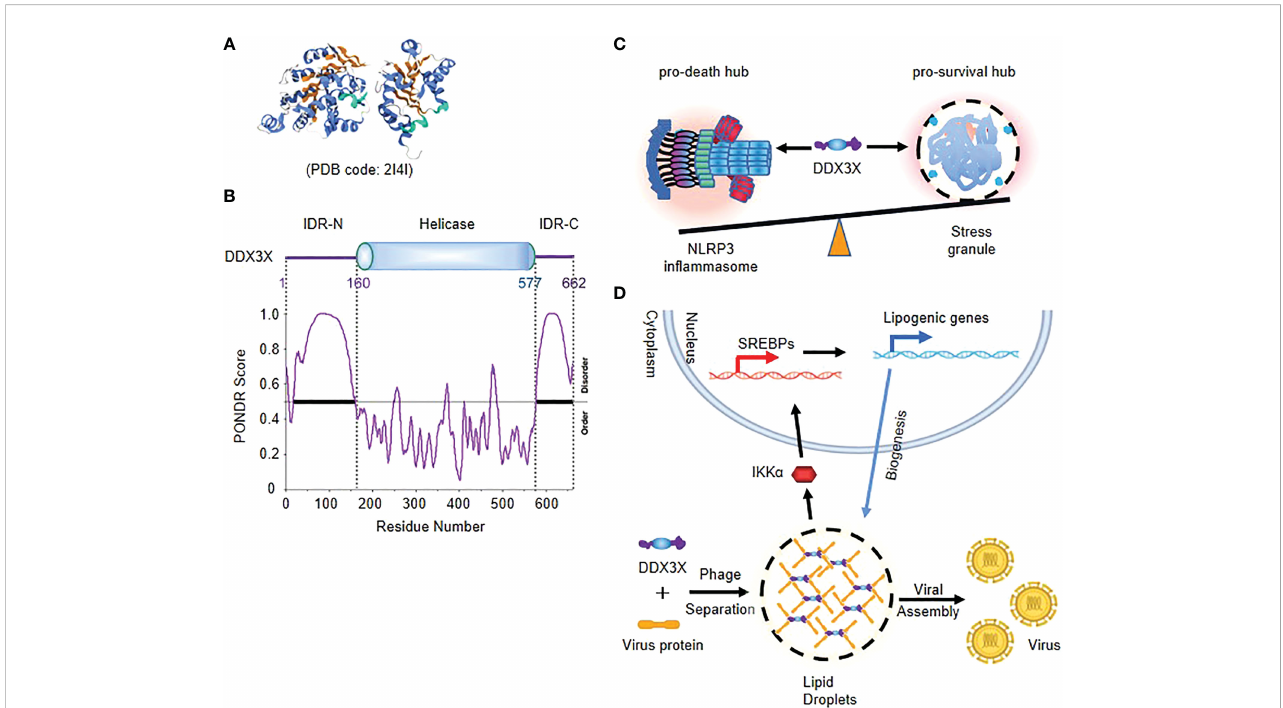
FIGURE 2 Phase separation of DDX3X decides the cell fate under stress (A) Crystal structure of helicase core (V168-G582) of DDX3X. (B) The schematic of the domain structure and the intrinsic disorder pro fi le of human DDX3X obtained by PONDR ® are shown. (C) Model of competition of DDX3X between the pro-survival stress granules and the pyroptotic NLRP3 in fl ammasome activation. (D) Model of DDX3X-enhanced lipogenesis and viral assembly. IDR of DDX3X facilitates the translocation of virus proteins to the liquid droplet surface of DDX3X granules, and leads to IKK- a activation and SREBP-mediated elevated expression of lipogenic